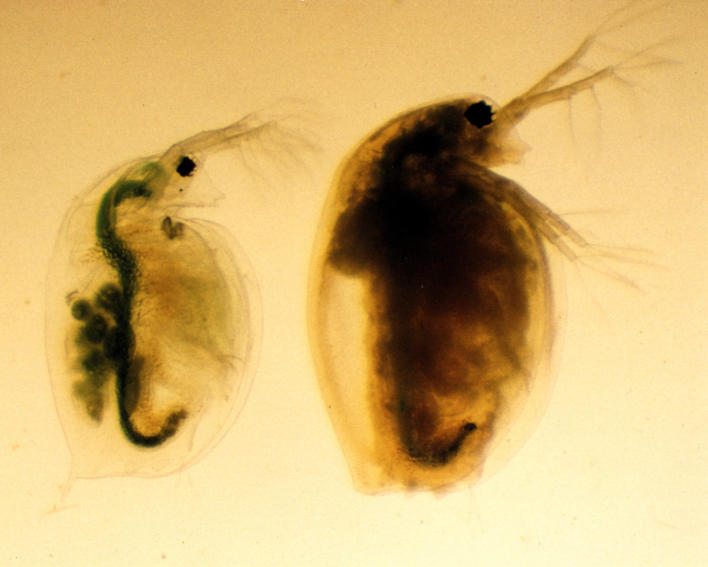
Exposing
Daphnia host clones to spores from the castrating bacterium
Pasteuria ramosa provides experimental evidence that parasite fitness is maximized at intermediate levels of virulence.